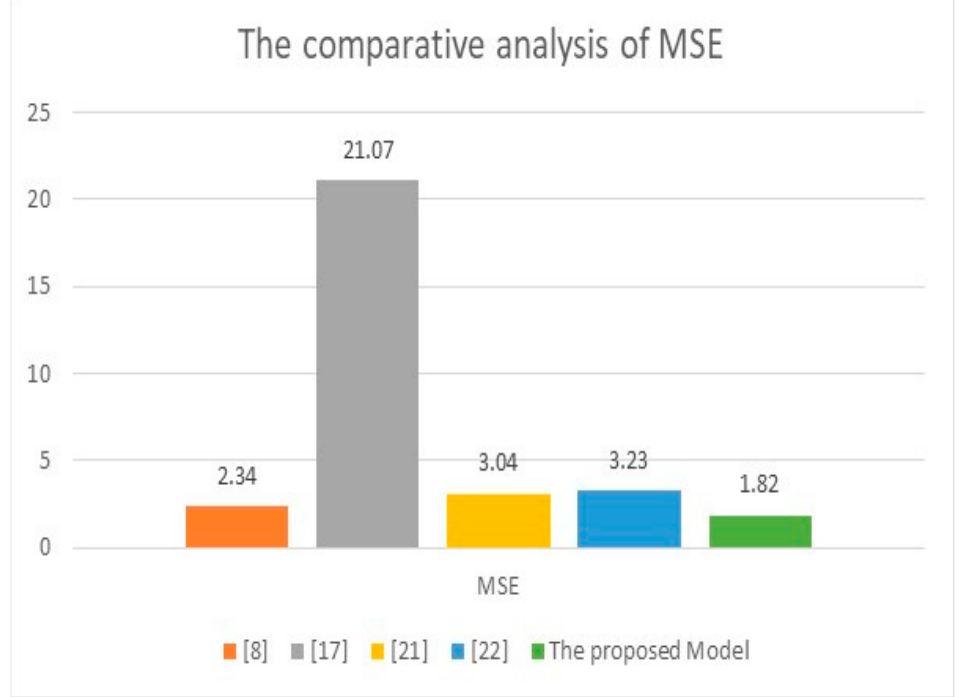
Figure 12. The comparative analysis of MSE between the presented model and some developed algorithms. algorithms